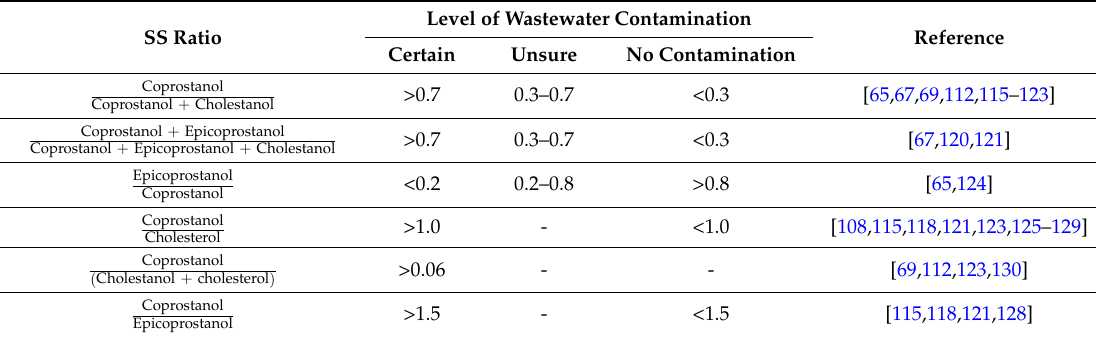
Table 2. SSs Indices for identification of wastewater contamination.